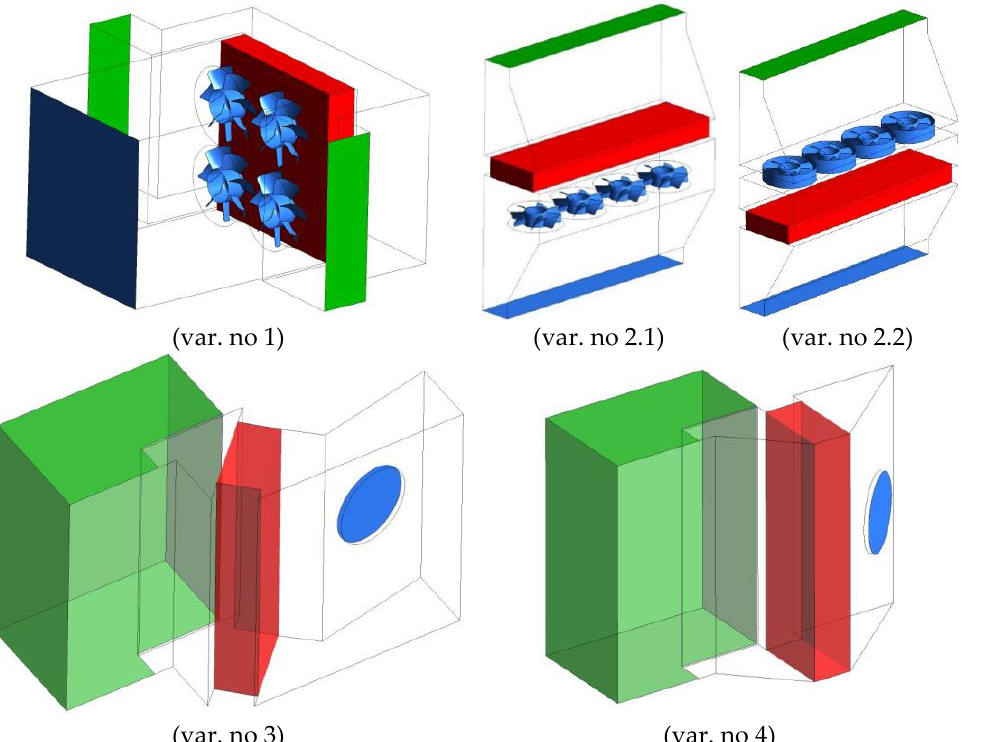
Figure 7. Simulated CFD models for simulation-based optimization of the outdoor unit. Variant no. 1 with four axial fans and flat square evaporator on the low-pressure side of the fans. Variant no 2.1 with four axial fans and thin rectangular evaporator on the under-pressure side of the fans. Variant no. 2.2 with four axial fans and a thin rectangular evaporator on the overpressure side of the fans. Variant no. 3 with a single radial fan and compact evaporator on the low-pressure side of the fan. Radial outflow takes place at an angle of 20° with the building façade. Variant no. 4 with a single radial fan and a more compact evaporator (compared to var. 1 and 2) on the low-pressure side of the fan. Radial outflow takes place at an angle of 50° with the building façade. The inlet region is indicated in green, the outlet region in blue, and the evaporator in red.